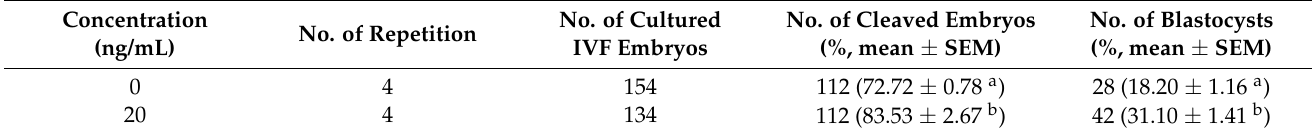
Table 4. Effects of supplementation of SDF1 during porcine oocyte IVM on subsequent development of IVF embryos.